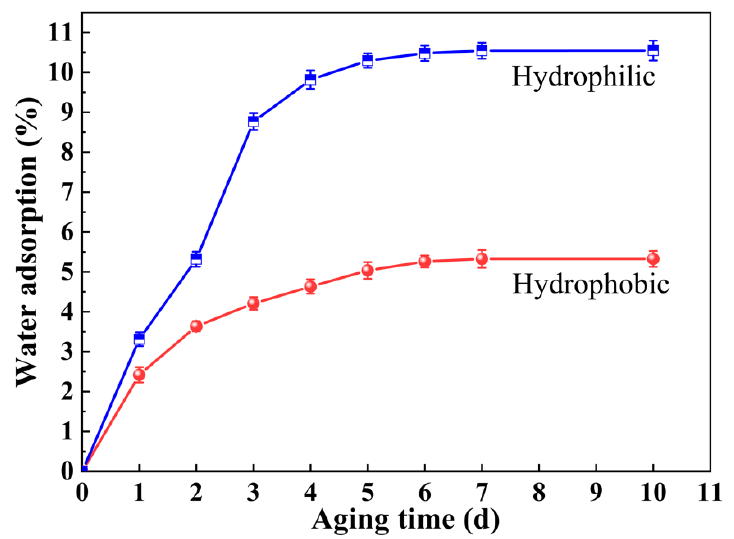
Figure 9. Water absorption diagram of hydrophilic ZrO 2 -SiO 2 and hydrophobic ZrO 2 -SiO 2 xerogels.